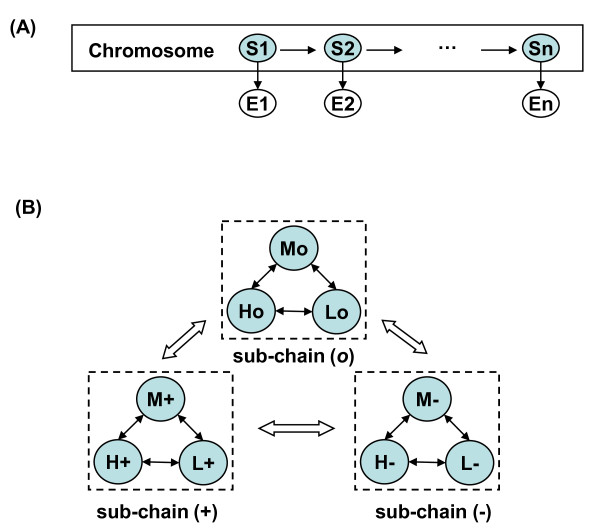
vCGH model structure. (A) vCGH model presented as a Bayesian network. The shaded nodes S1, S2, ..., Sn represent hidden state variables for genes and the white nodes E1, E2, ..., En represent the observations for the variables. There are three symbols for GEP observations, "H", "L" and "M" for high, low and medium expression, respectively. There are nine hidden states that GEP profiles superimposed on CGH, H+, L+, M+, H-, L-, M-, Ho, Lo and Mo, where = "+", "-" and "o" for gain, loss and normal CGH status, respectively. (B) State transition diagram of vCGH model. The model is a single HMM chain integrating three Markov sub-chains: (+), (-) and (o). In each sub-chain, a Markov chain is graphically shown as a collection of states, with arrows between them describing the state transitions within a CNA (gain, loss or normal). There are also arrows between sub-chains, describing the state transitions from one CNA to another CNA.